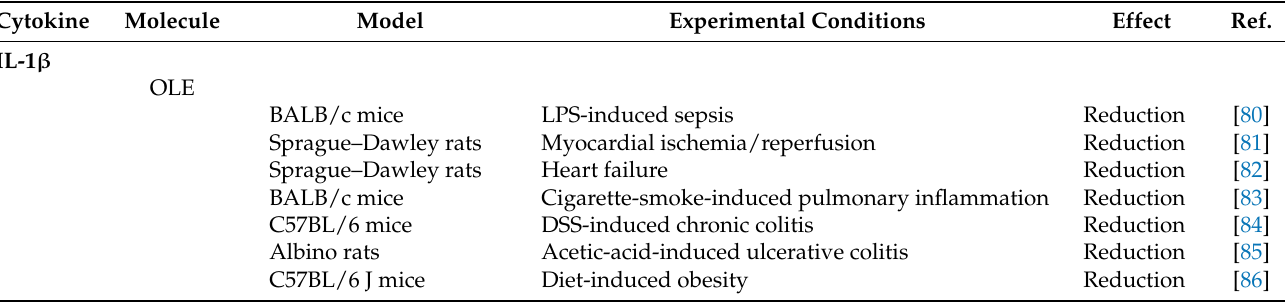
Table 2. Effects elicited by OLE and HT on pro- and anti-inflammatory cytokines in